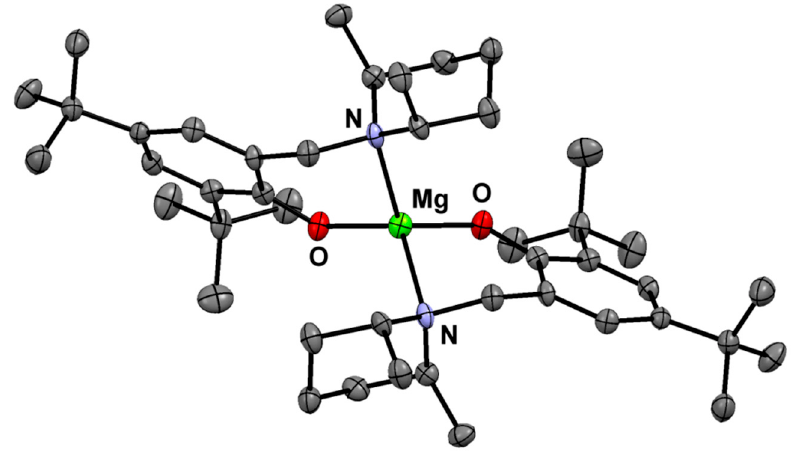
Figure 2. Molecular structure of (L dmp ) 2 Mg.